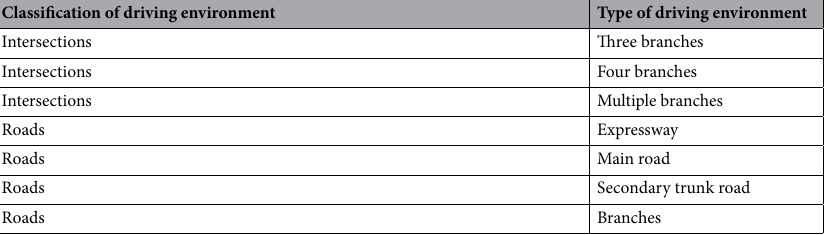
Table 1. This table mainly describes the driving environment classification and driving environment type. The driving environment classification includes intersection and road. The driving environment type is divided into different branches and roads. Allowing for two points above, so as to obtain the judgment of the driving